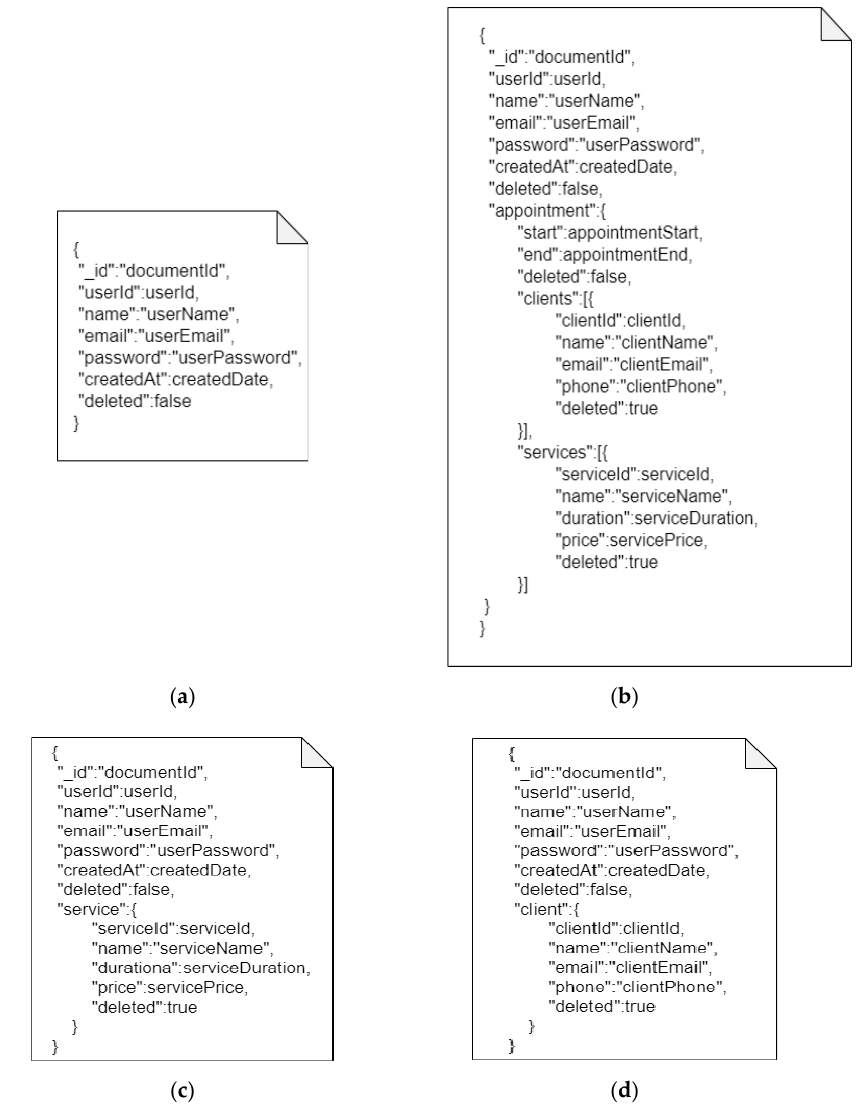
Figure 2. Application’s document structure: ( a ) User document; ( b ) Appointment document; ( c ) Ser- vice document; ( d ) Customer document.